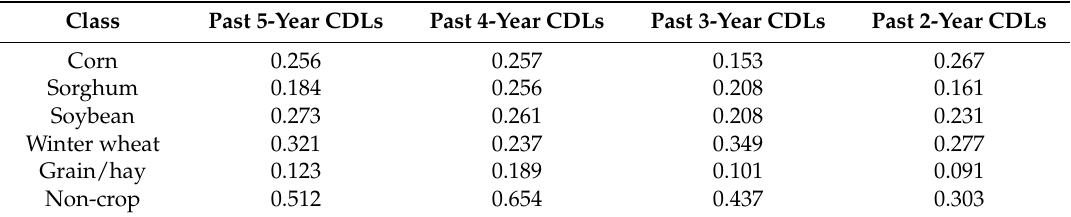
Table 8. Interquartile range of uncertainty values at new training pixels for four different past CDL combination